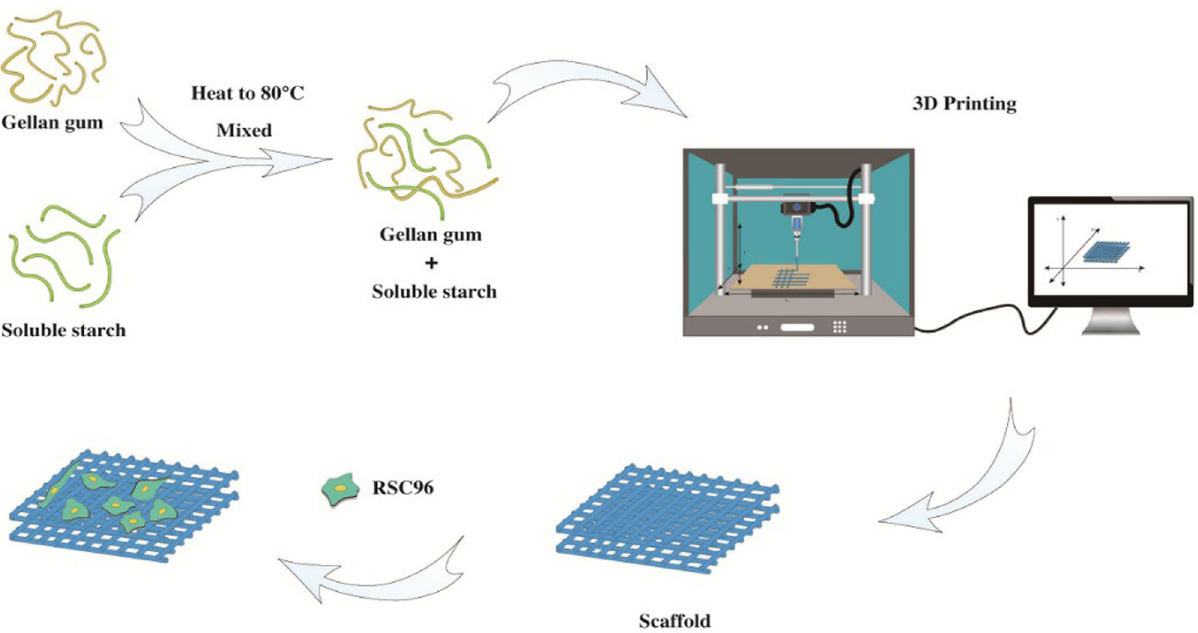
Figure 1: The preparation of the GG/ST